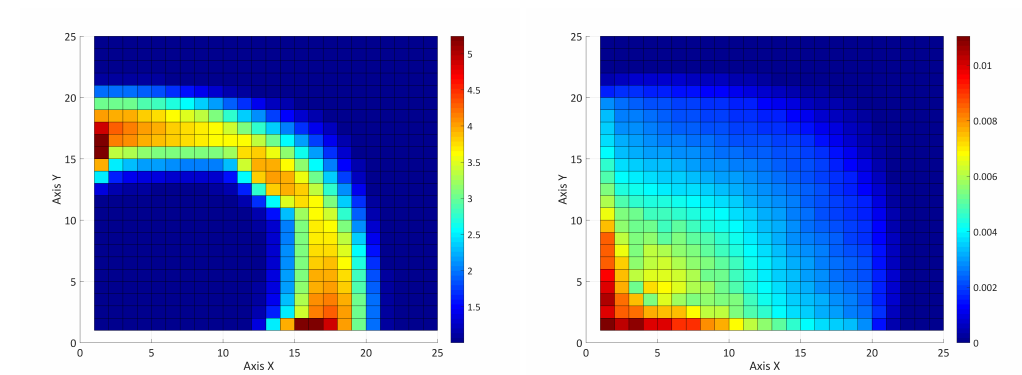
Figure 14. Polymer concentration profile after 1000 in a surfactant + polymer flooding (overlapped— left ) and combined chemicals after 1000 days in a polymer + surfactant flooding (overlapped— right ).